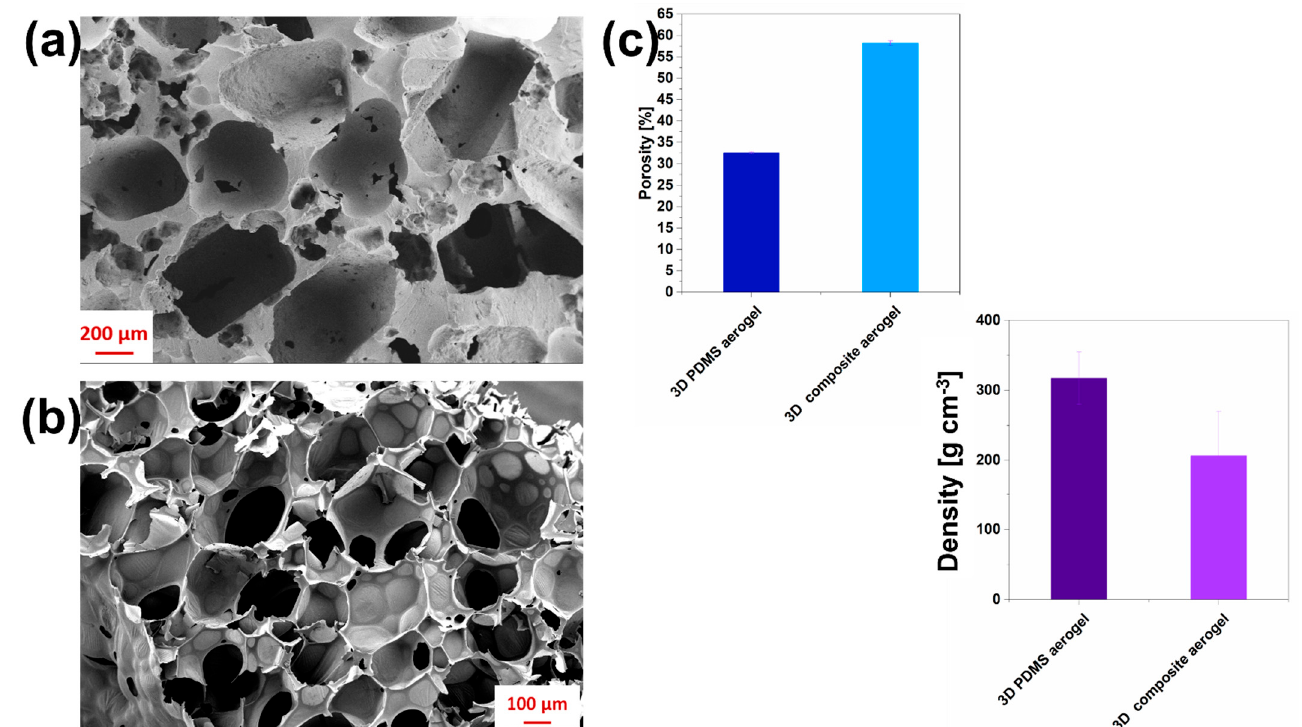
Figure 2. Morphological properties of ( a ) 3D PDMS aerogels ; ( b ) 3D composite aerogel , based on PDMS/MWCNTs; and ( c ) density and porosity trends characterizing all samples, 3D PDMS aerogels and 3D composite aerogels , respectively.